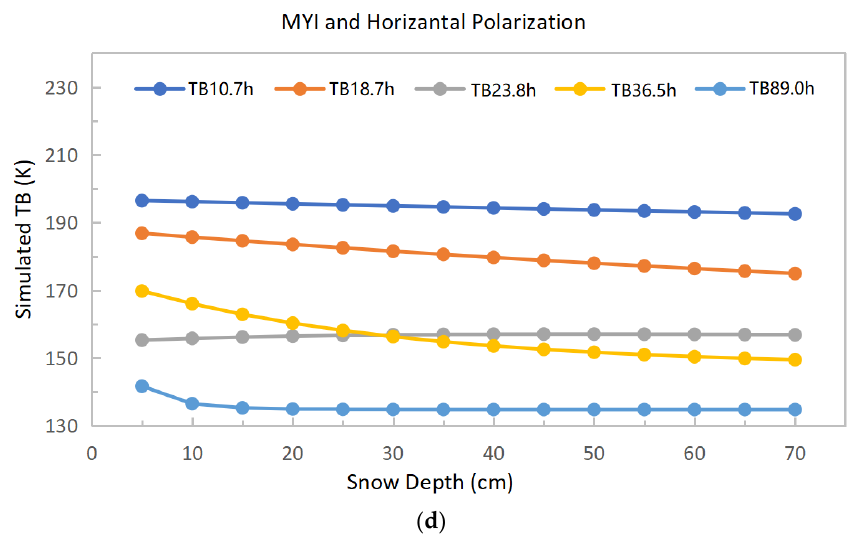
Figure 3. Variation of simulated TBs on each channel with snow depth. ( a ) Vertical polarization on FYI; ( b ) horizontal polarization on FYI; ( c ) vertical polarization on MYI; ( d ) horizontal polarization on MYI.